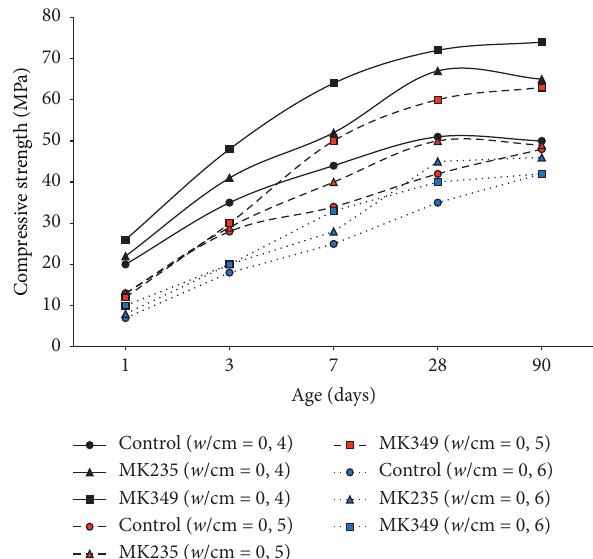
Figure 7: Average compressive strength with respect to concrete age for w / b � 0.40, 0.50, and 0.60 [23].